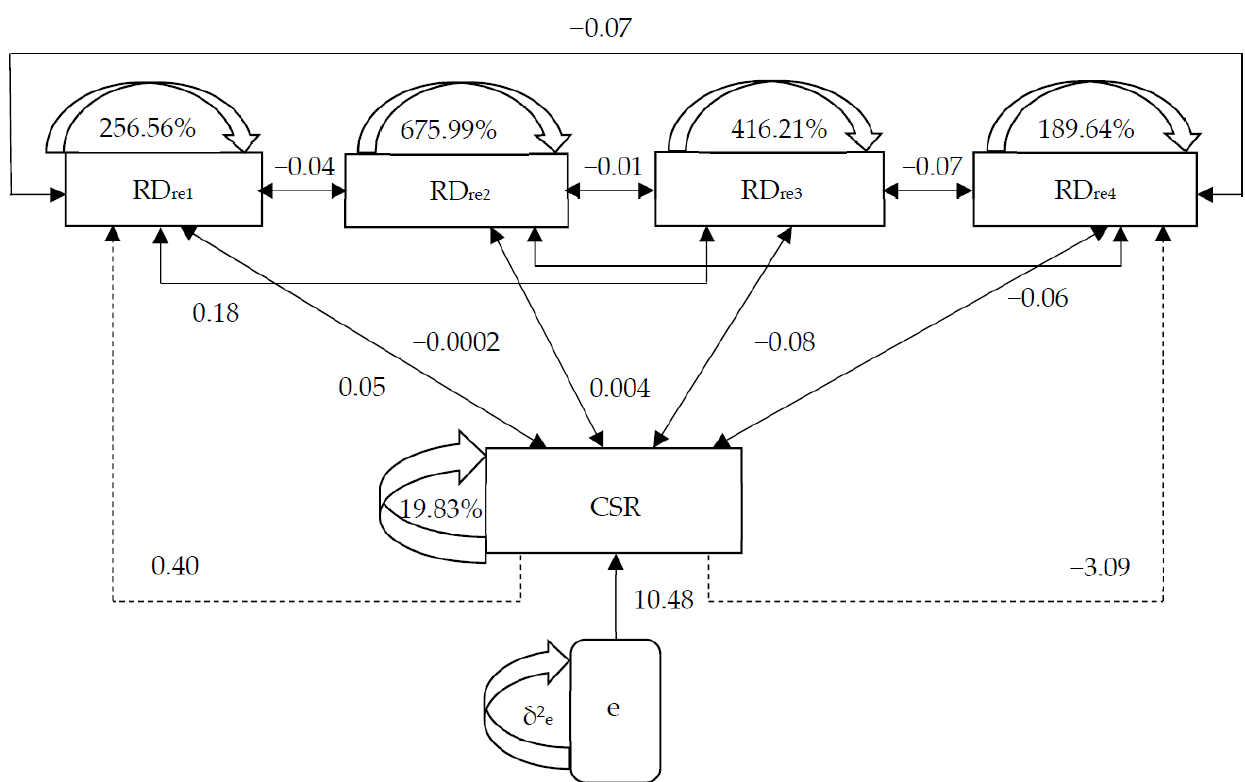
Figure 4. Structural equation modeling (SEM) result. Source: developed and compiled by the au- thors.